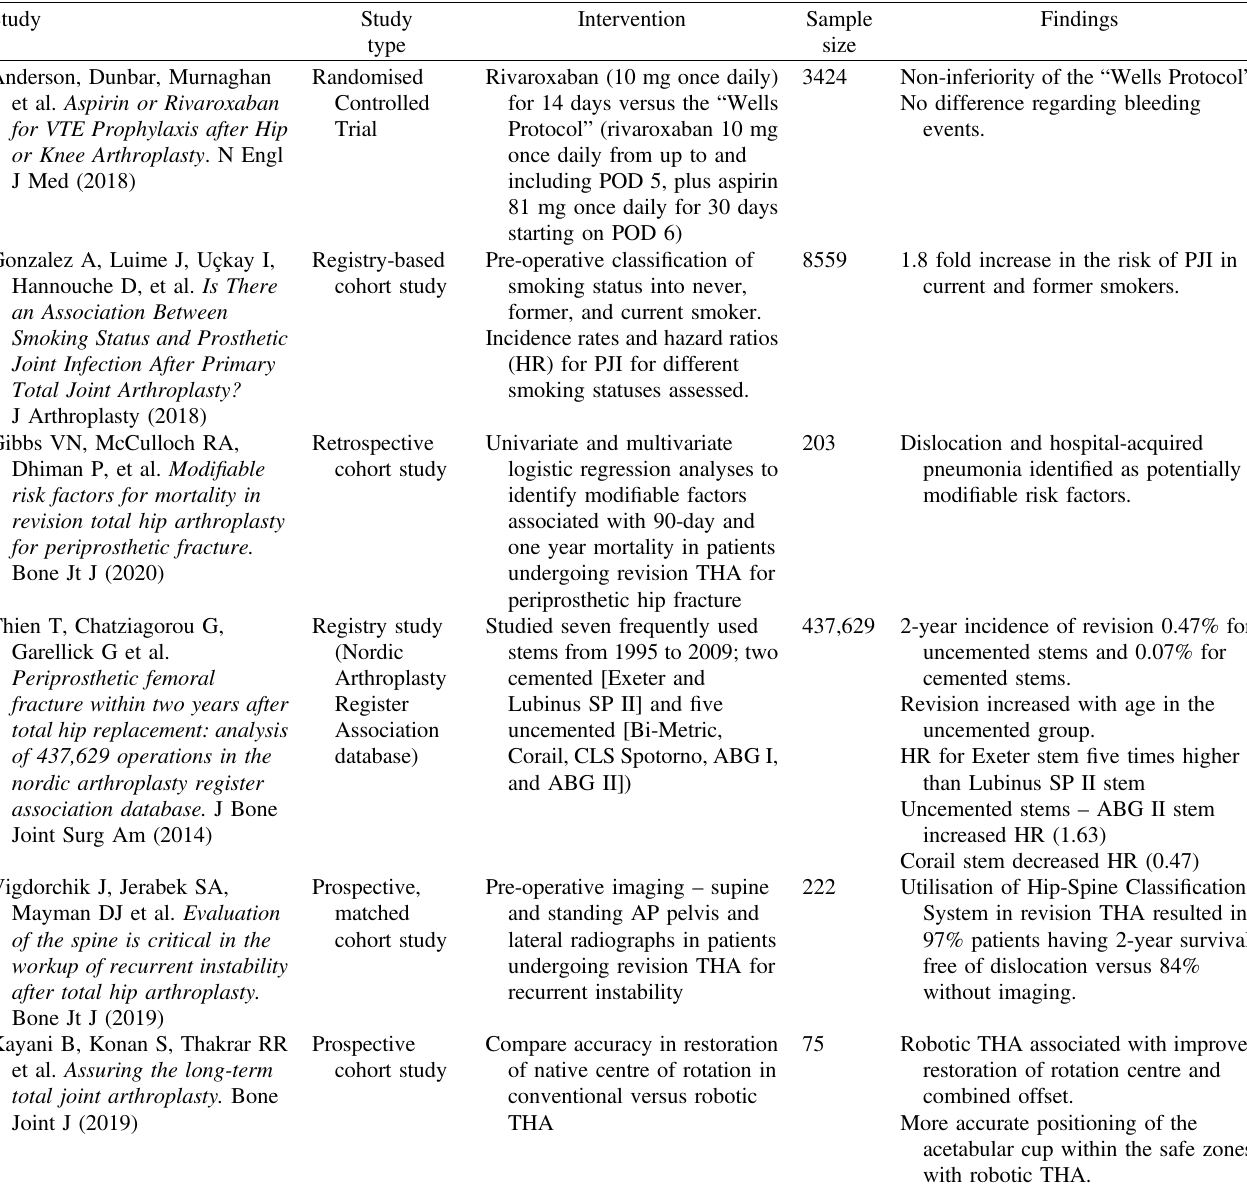
Table 4. Summary of key studies included in the